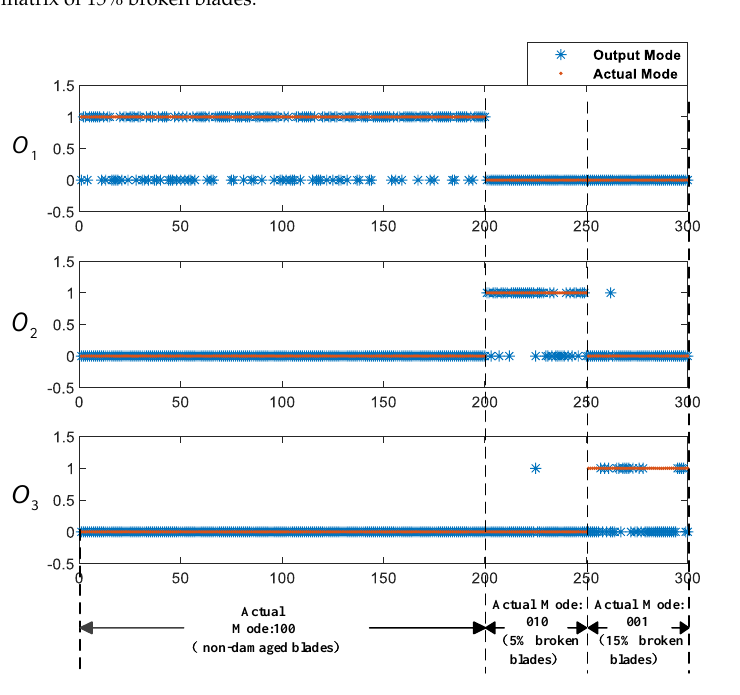
Table 5. The training design of the BP-based FDI model.